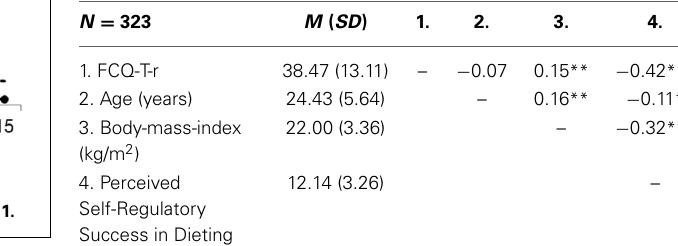
Table 2 | Descriptive statistics of and correlations between variables of study 1.